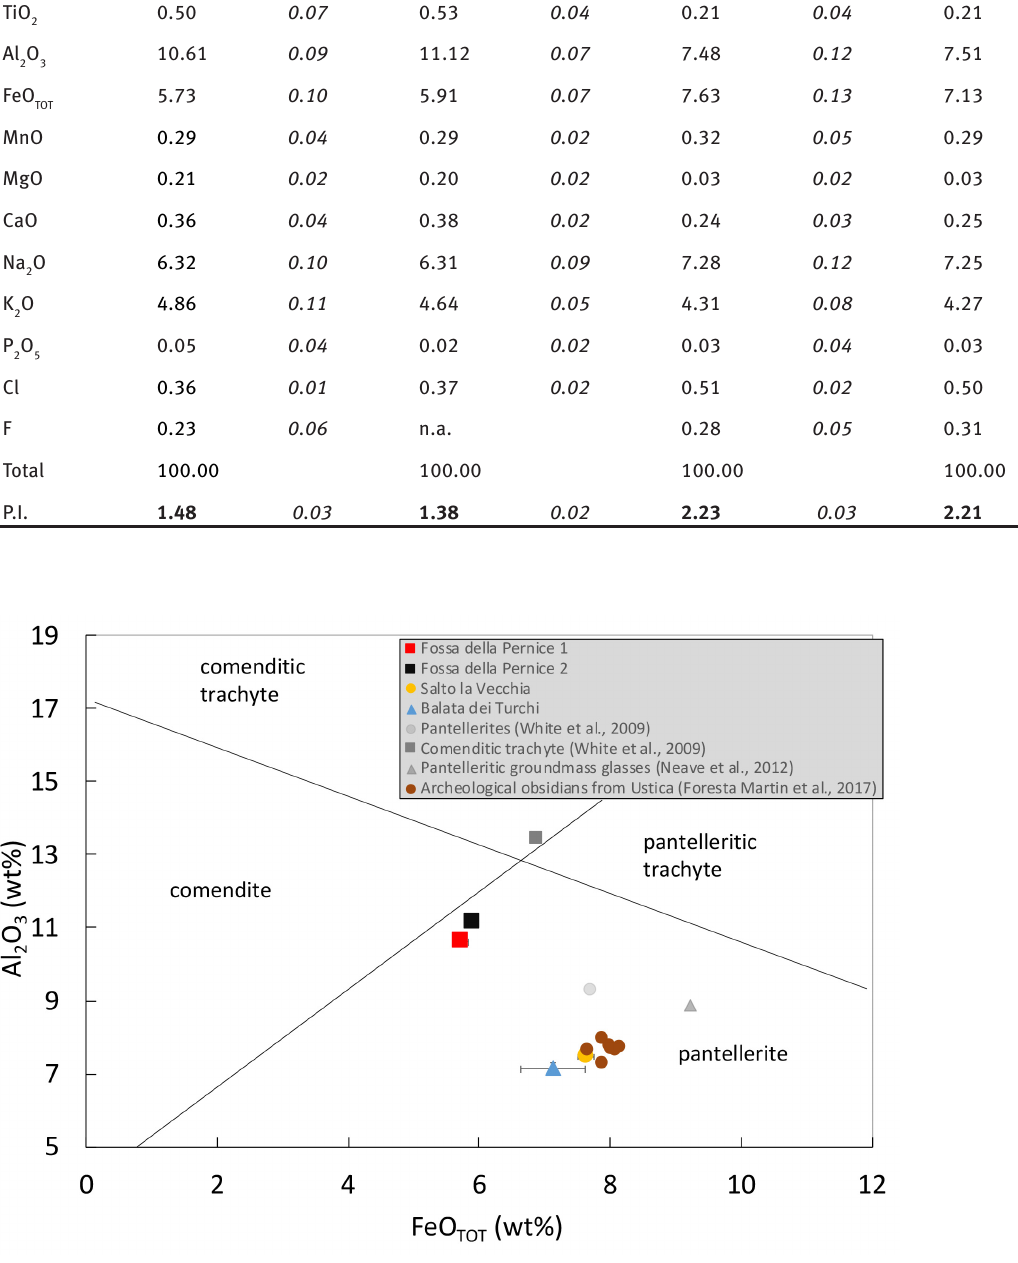
Figure 7: Macdonald (1974) classification diagram for Pantelleria peralkaline rocks (new analyses by electron microprobe). Literature data are whole-rock analyses from White et al. (2009) and electron microprobe groundmass glass analyses from Neave et al. (2012). Selected archaeological obsidians from Bronze age settlements on Ustica with a pantelleritic chemical fingerprint are plotted for comparison (source: Foresta Martin et al.,